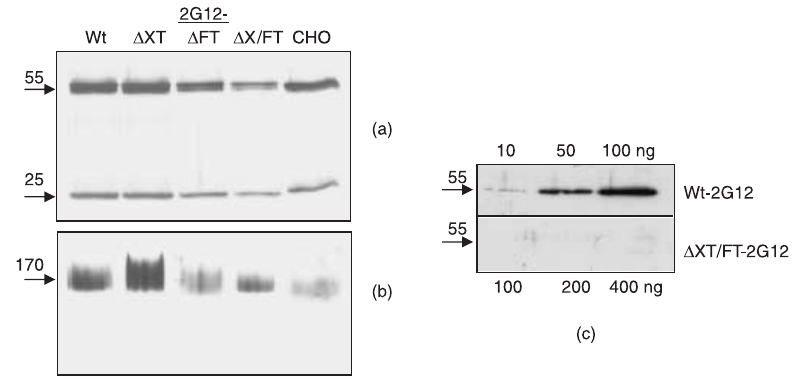
Figure 3 Silver-stained sodium